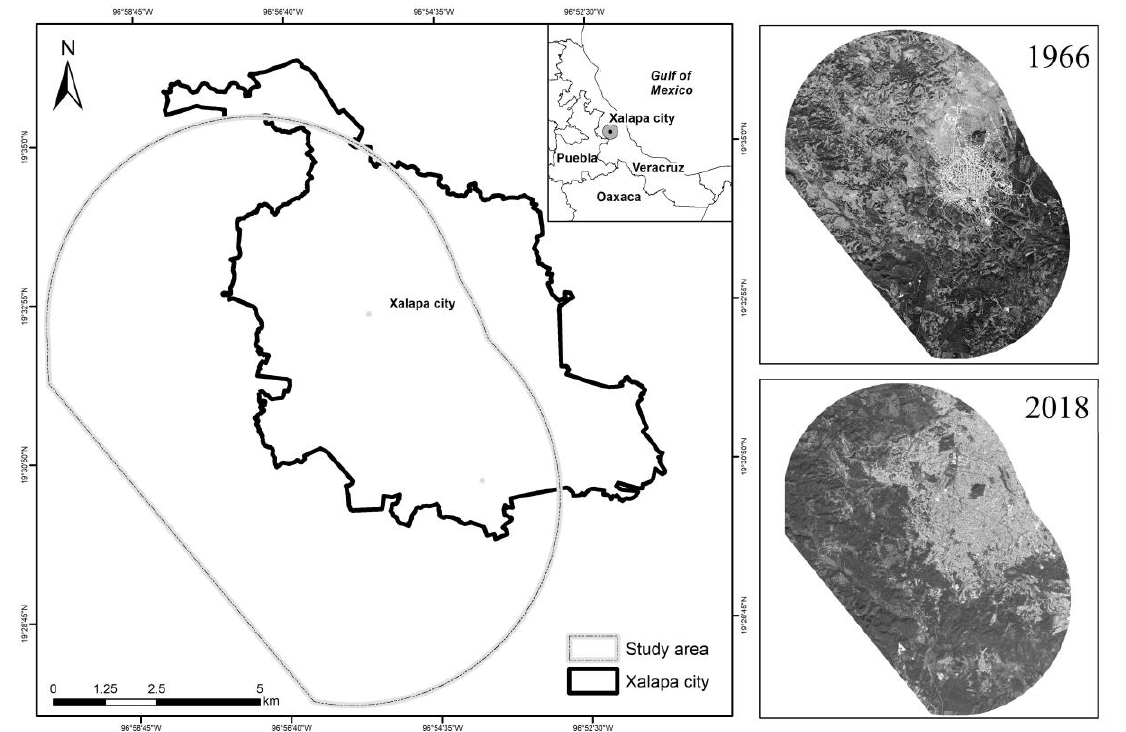
Figure 1. Location and boundaries of the study area: the periphery of Xalapa city. Satellite image of 1966 and